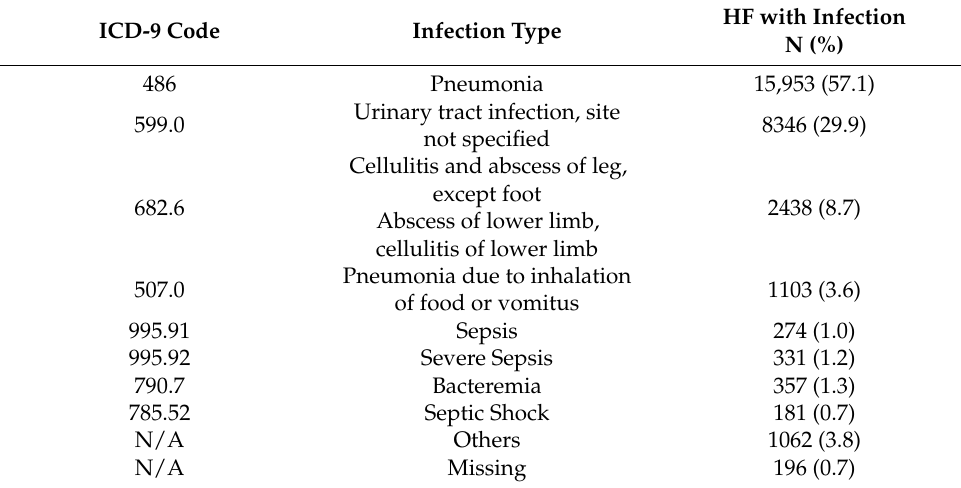
Table 2. Type of acute bacterial infection.